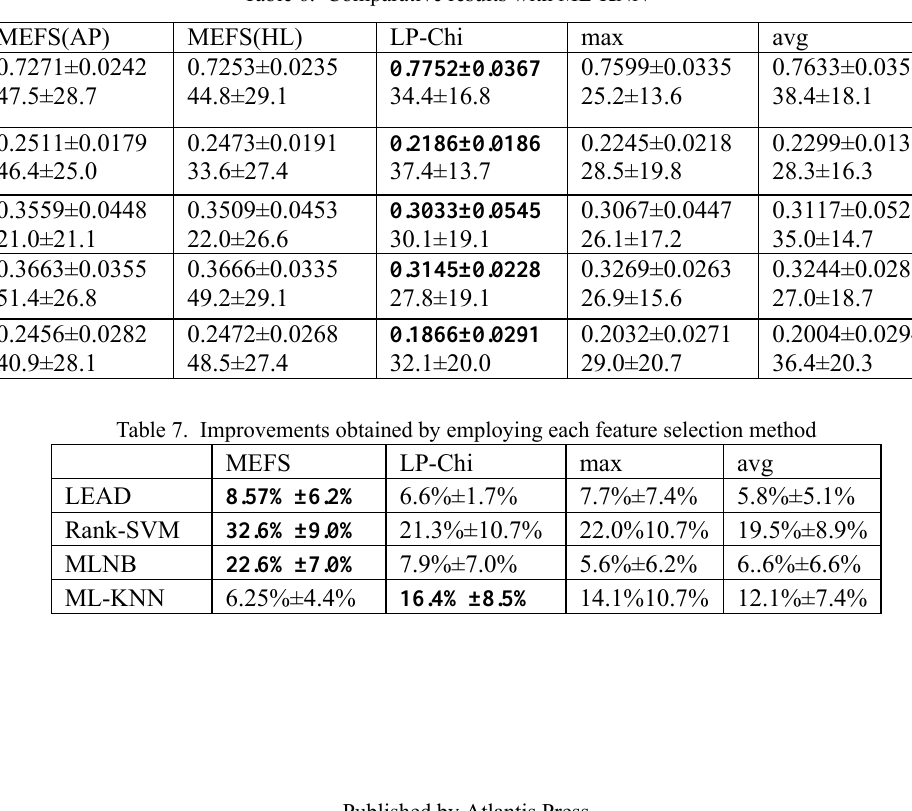
Table 6. Comparative results with ML-KNN